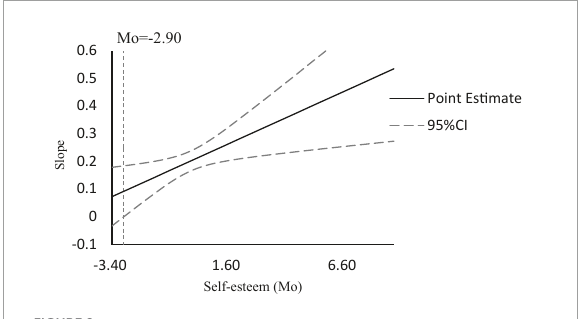
FIGURE2 Moderating effects of self-esteem on the relationship between sense of meaning in life and prosocial behavior in